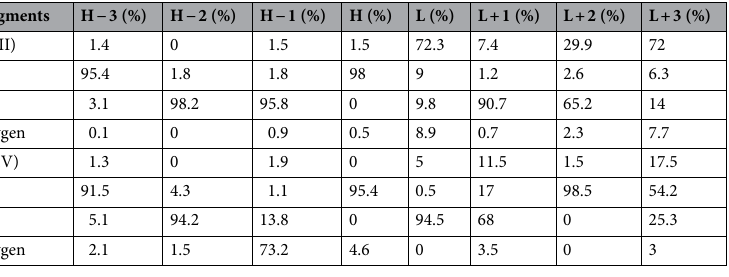
Table 5. Composition of the frontier molecular orbital for all studied complexes by using DFT/B3LYP/Cep- 31G.